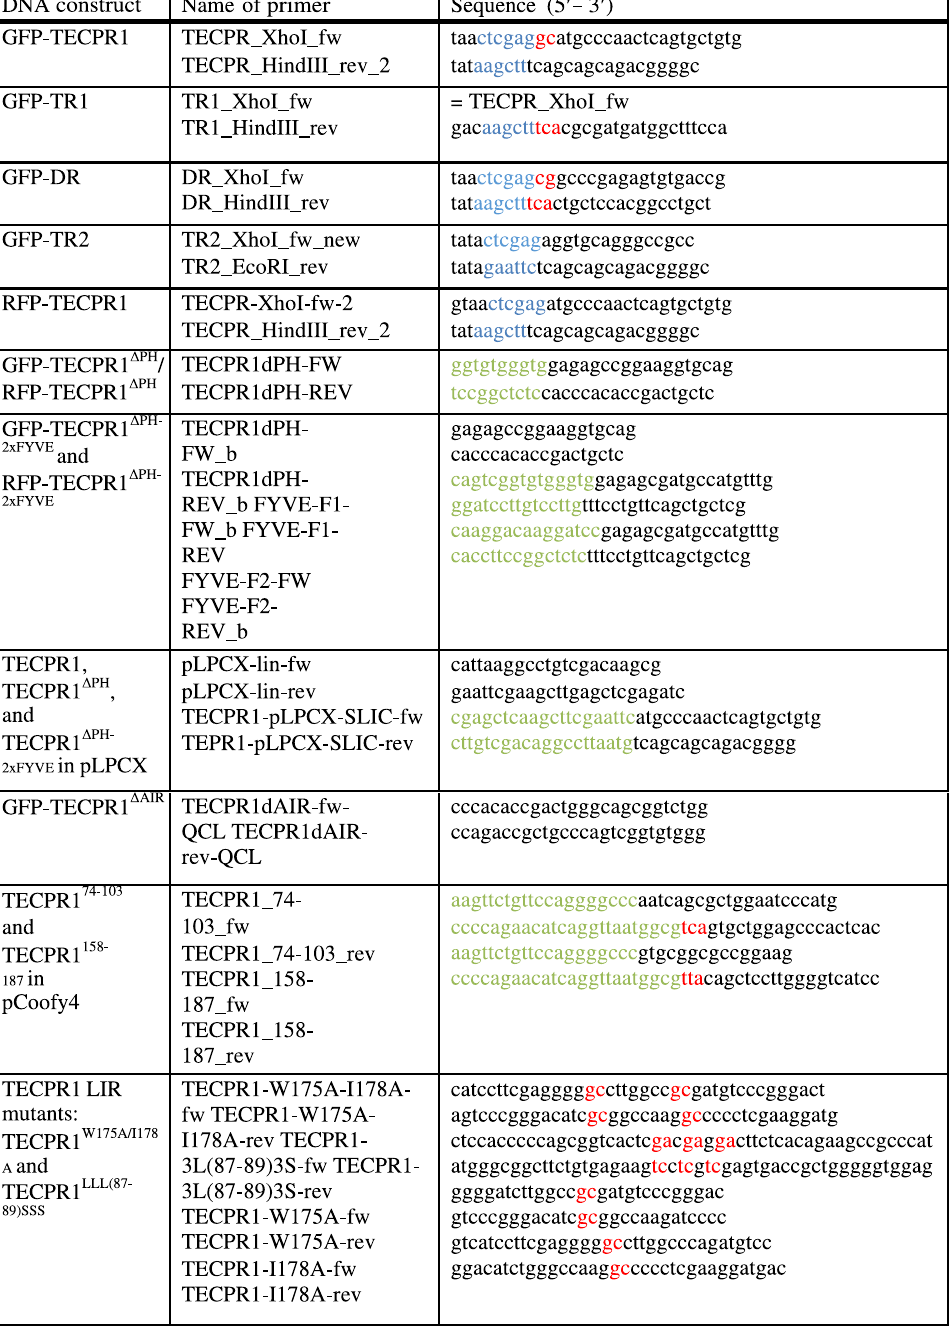
Primers used for cloning of RFP-2xFYVE. Gene-speci fi c sequences are black, homolog sequences to either the linearized vector or the preceding ORF sequence are marked in green, and additionally added base pairs are marked in red.